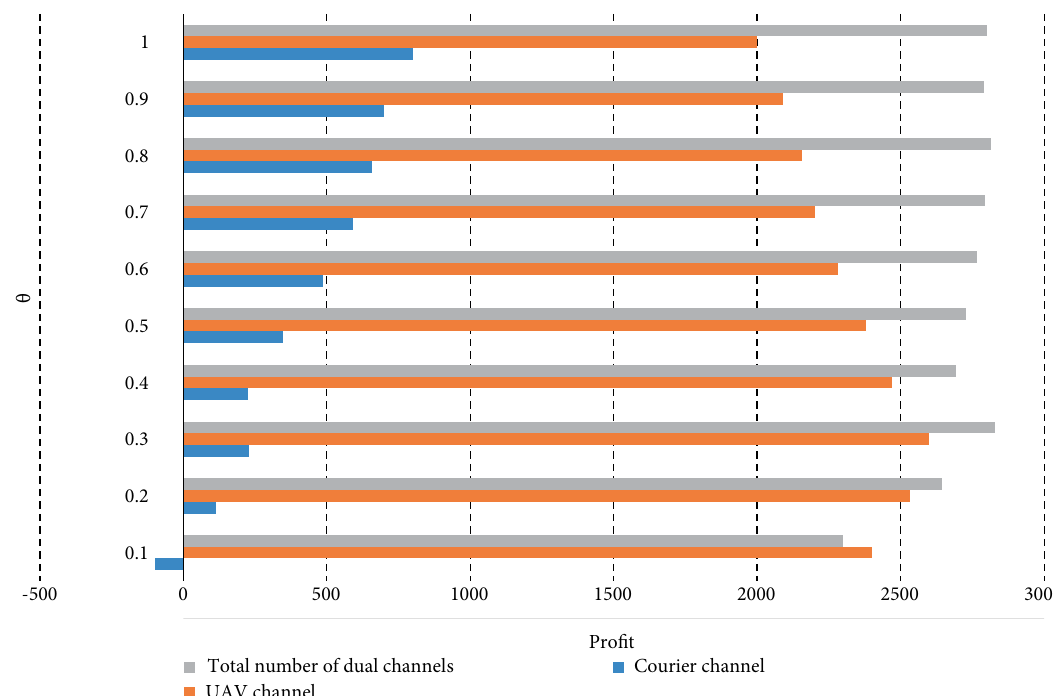
Figure 4: The impact of the market allocation proportion factor 𝜃 on UAV channels, courier channels and the total expected